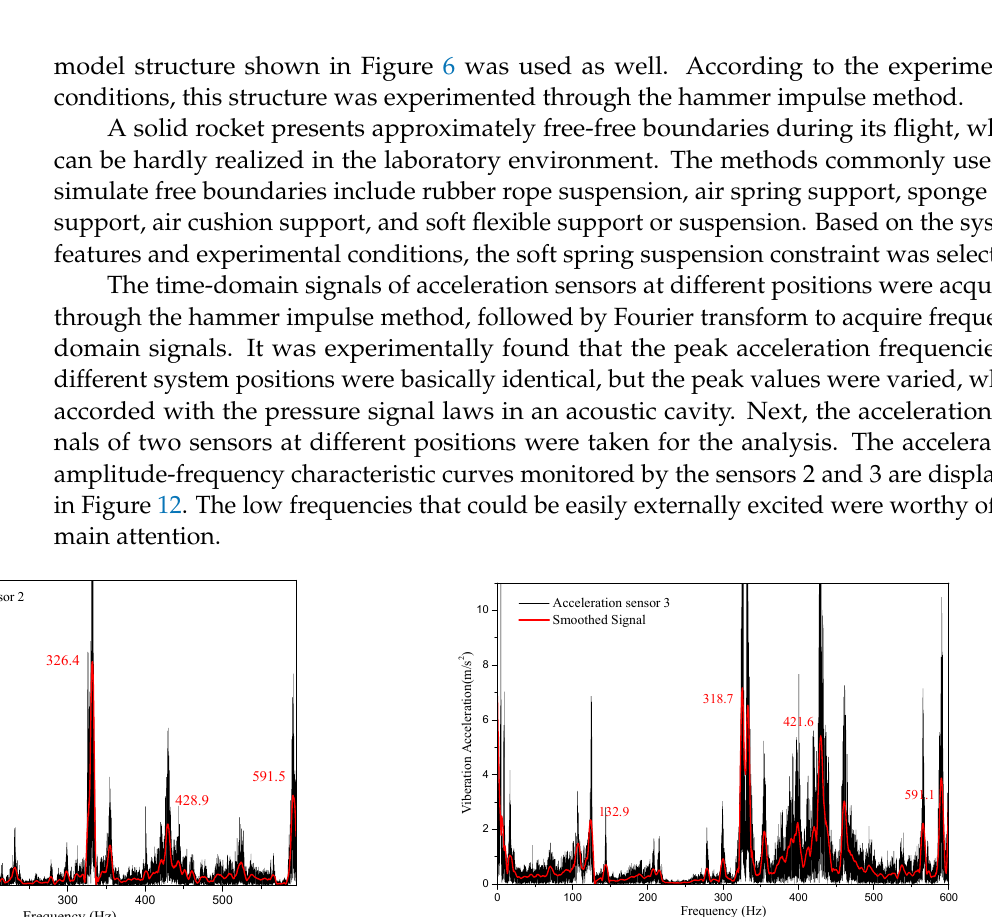
Table 5. Comparison of simulated values for the first four order shell modes with different mesh sizes. Order/Shell